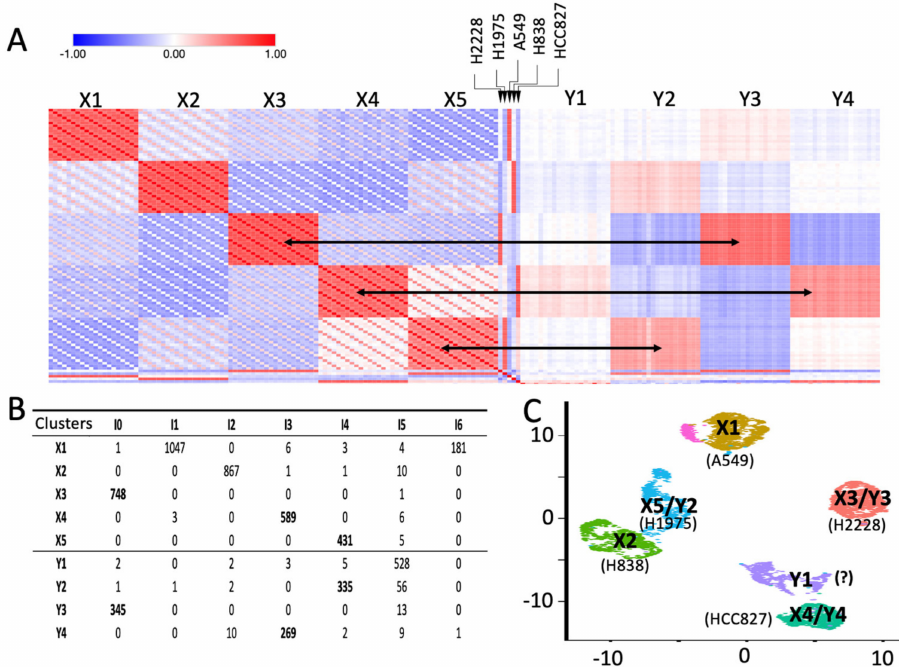
Figure 3. Comparing independent datasets using SCA pseudo-bulk. ( A ) Pearson similarity matrix generated comparing RNA-5c (X1–5) and RNA-3c (Y1–4) clusters, together with the bulk cell lines transcriptome. Black arrows associate clusters with the higher similarity depicted among clusters. It is notable that SCA pseudo-bulk experiments are very effective in capturing the similarity among clusters from independent experiments. ( B ) Seurat integration table. On the columns are shown the integration clusters and on the rows are the number of cells from each RNA-5c and RNA-3c cluster present in the integration clusters. ( C ) UMAP (Uniform Manifold Approximation and Projection) plot of the Seurat integrated clusters. Y1 cell line association is indicated with a question mark since, in Figure 2D, Y1 seems to be associated with H1975, as instead, by Seurat integration and SCA, pseudo-bulk Y1 shows higher similarity for HCC827 than to